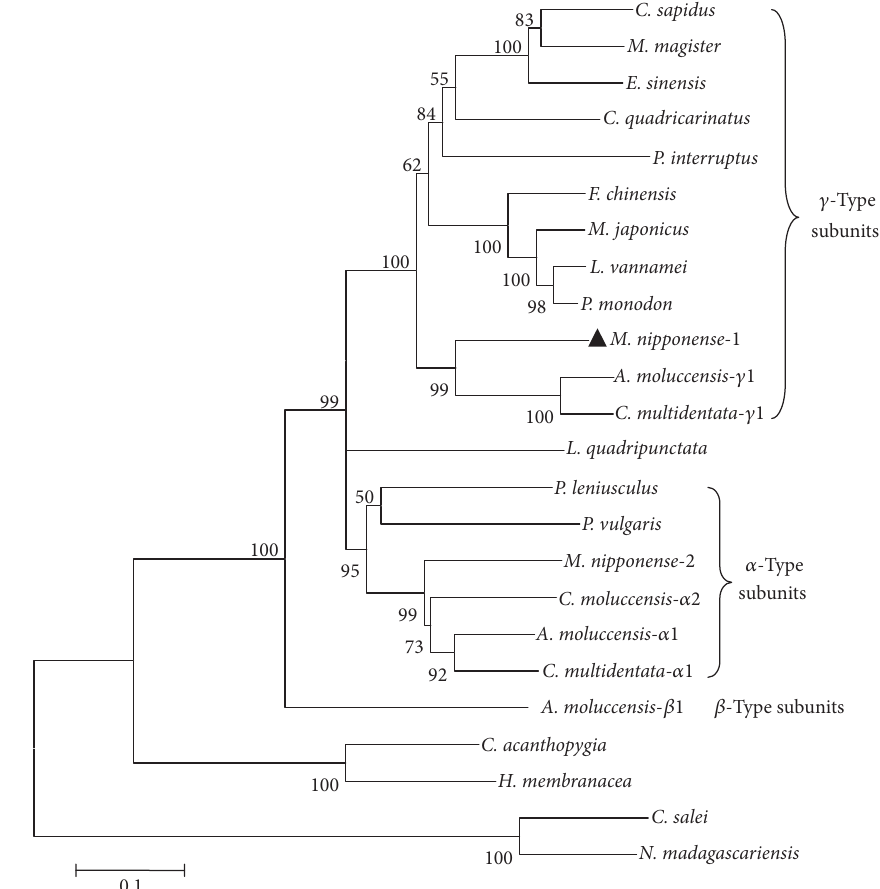
Figure 2: The phylogenetic tree based on the sequences of hemocyanin from different species. The amino acid sequences were derived from the GenBank as the following accession numbers: A. moluccensis - 𝛼 1 (CCF55379.1); A. moluccensis - 𝛽 1 (CCF55382.1); A. moluccensis -